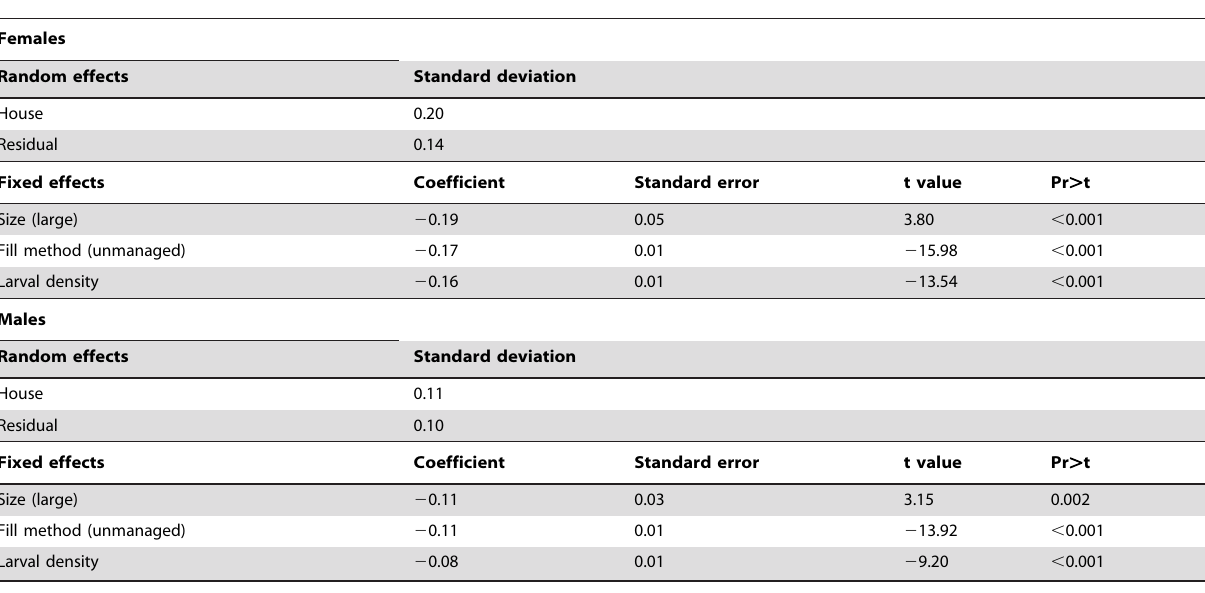
Table 2. Parameter coefficients for models predicting adult wing lengths.